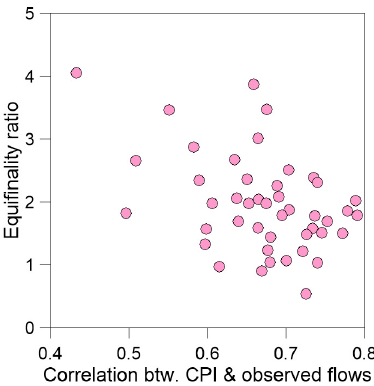
Figure 7. The input–output consistency vs. equifinality increased by replacing the hydrograph calibration with the FDC calibration. The equifinality ratio is defined as the ratio between the prediction areas of the 50 behavioural parameters gained from the FDC cali- bration and the hydrograph